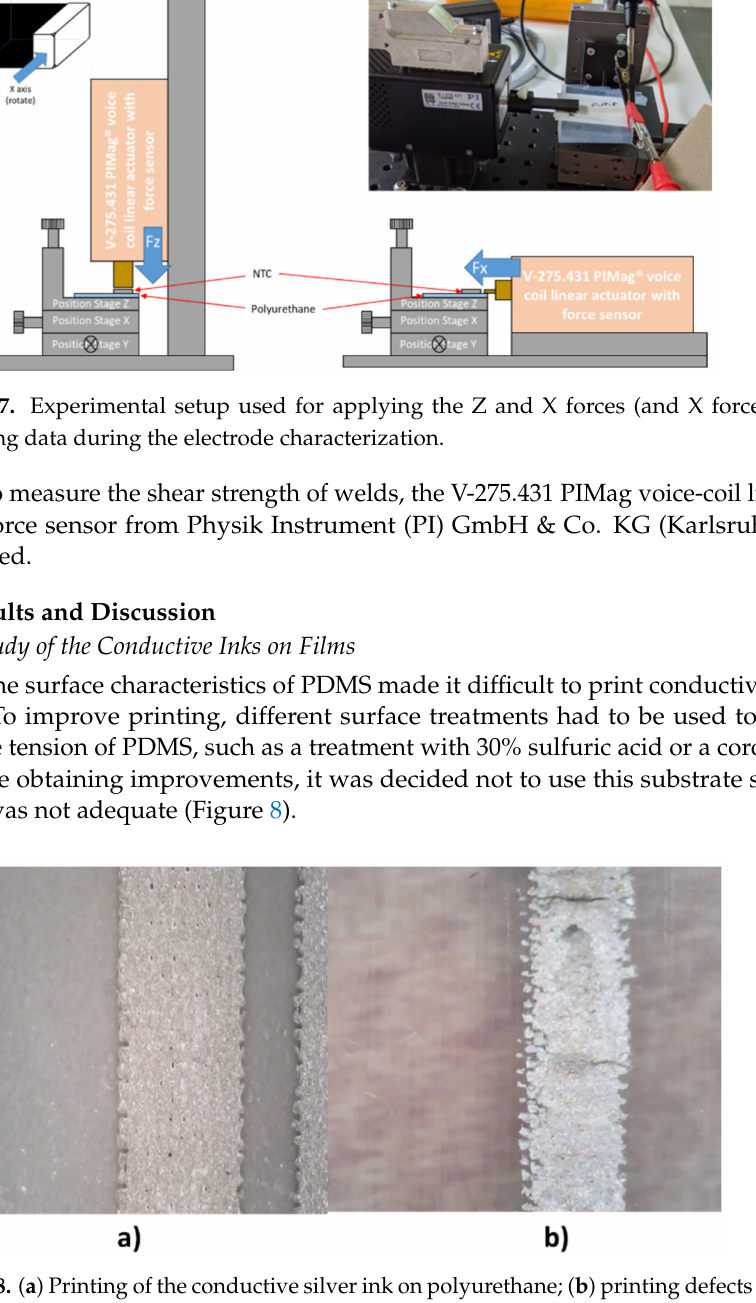
Figure 8. ( a ) Printing of the conductive silver ink on polyurethane; ( b ) printing defects of a conductive line on